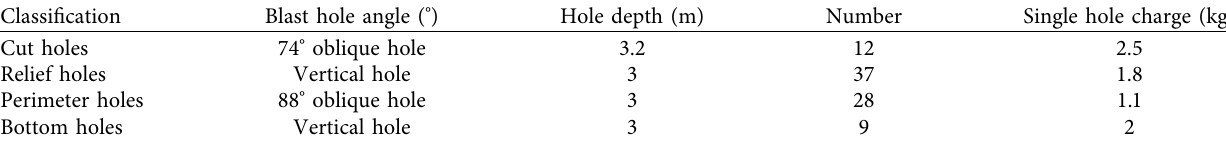
Table 2: Blast holes’ parameters in tunnel blasting.